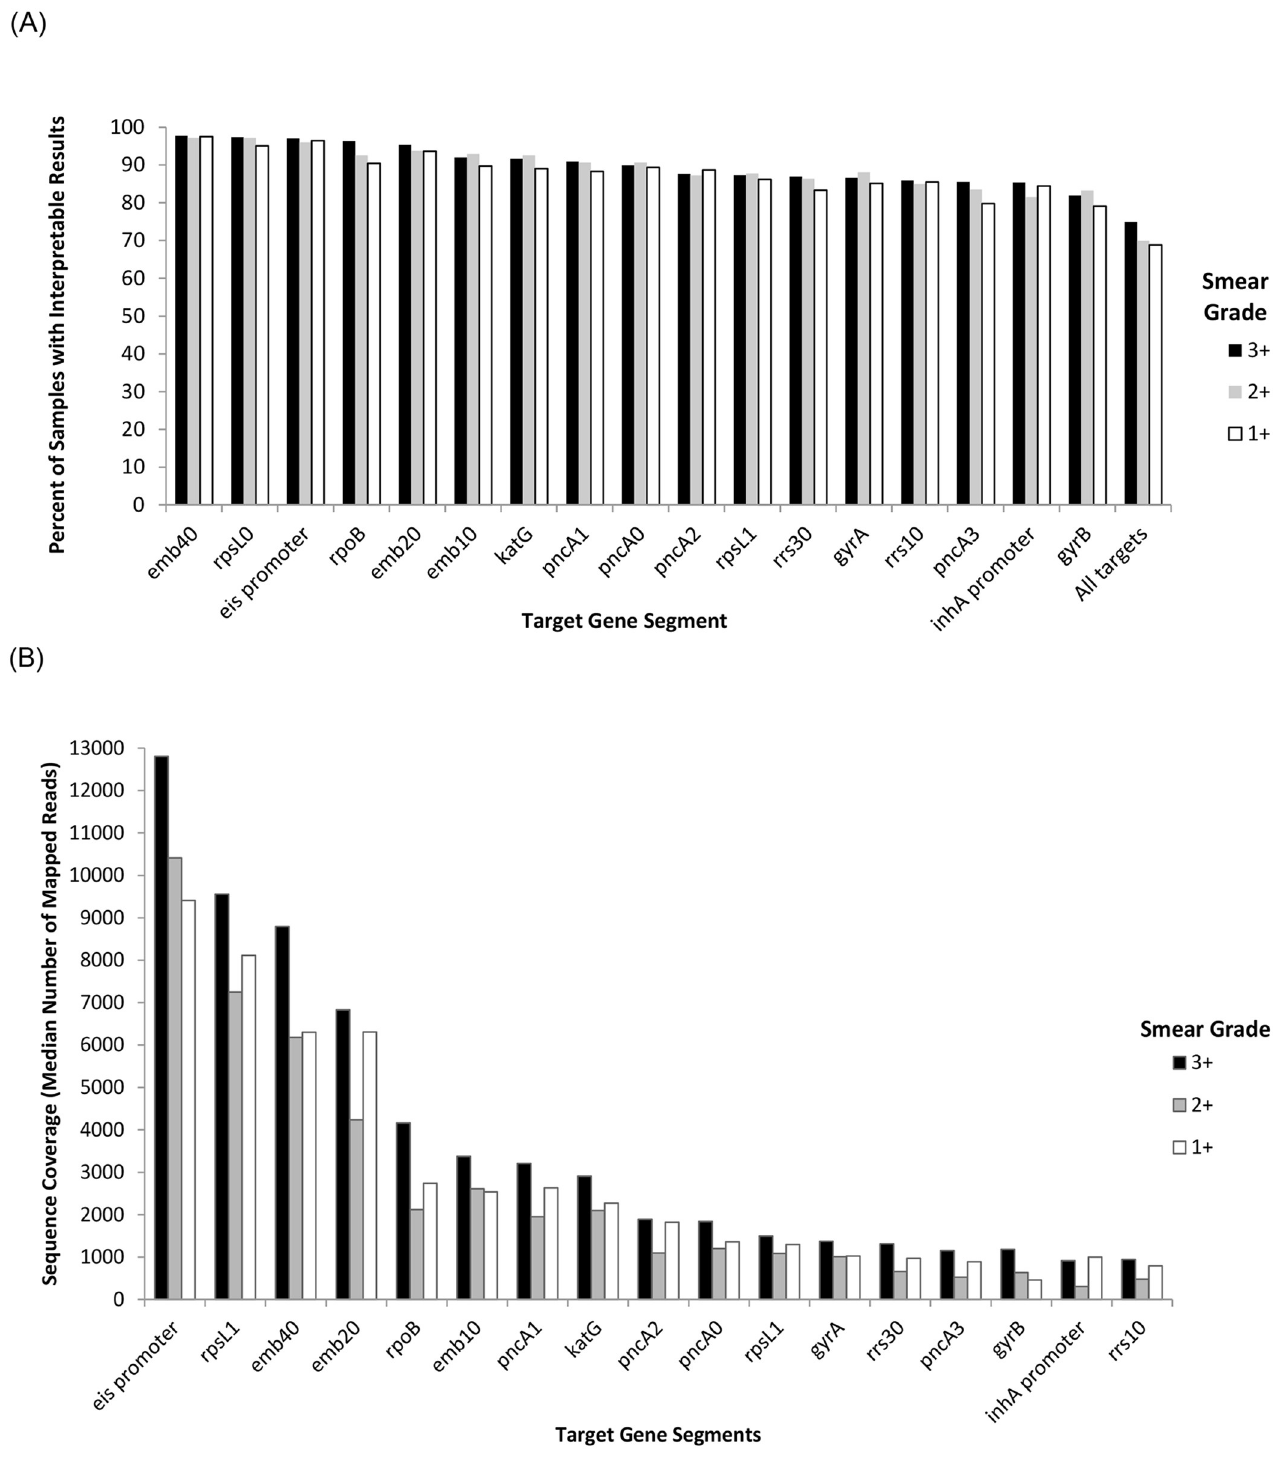
Fig 2. Percent of samples per smear grade with interpretable results and median number of mapped reads per target gene segment. A) Percent of samples per smear grade with interpretable results (coverage depth of 20X or greater) for all and specified target gene segments; B) Sequence coverage in median number of mapped reads per target gene segment, stratified by smear